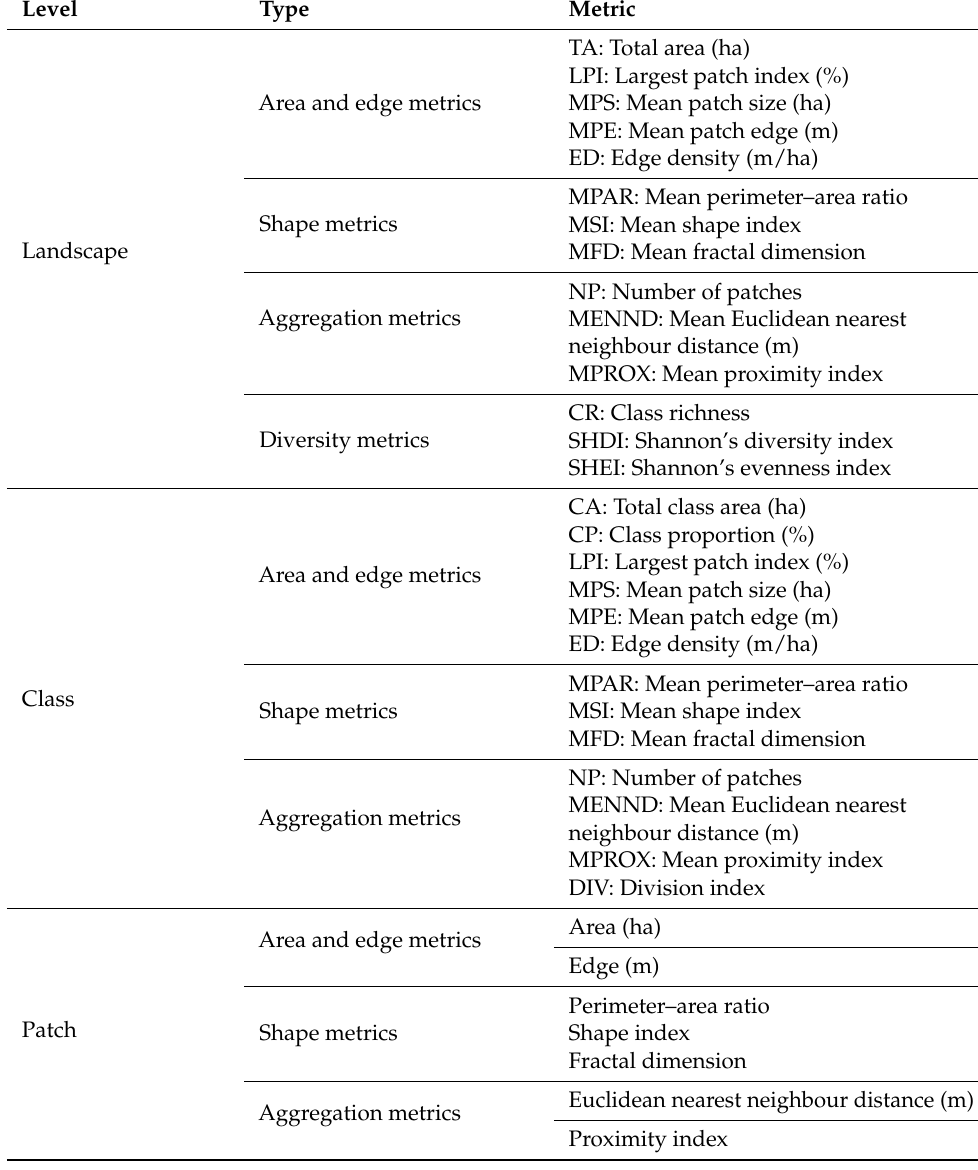
Table 2. Landscape metrics selected for this study (adapted from